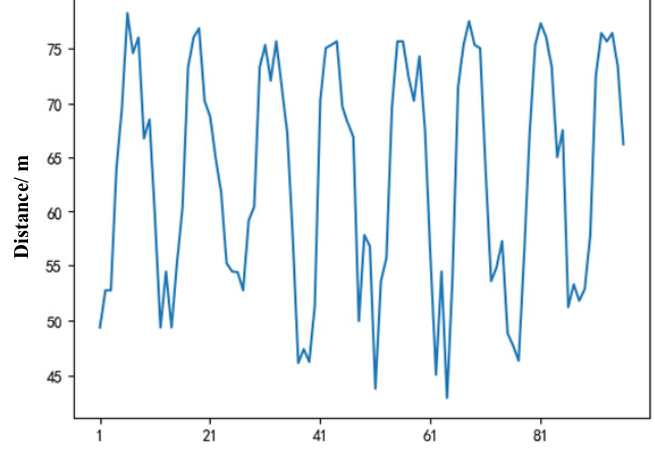
Figure 6. Offset azimuth trend.